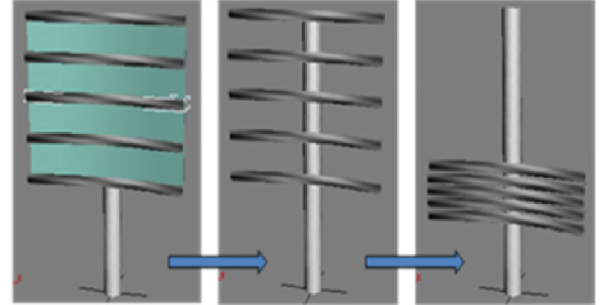
Fig. 6 Foldable lifting sails.